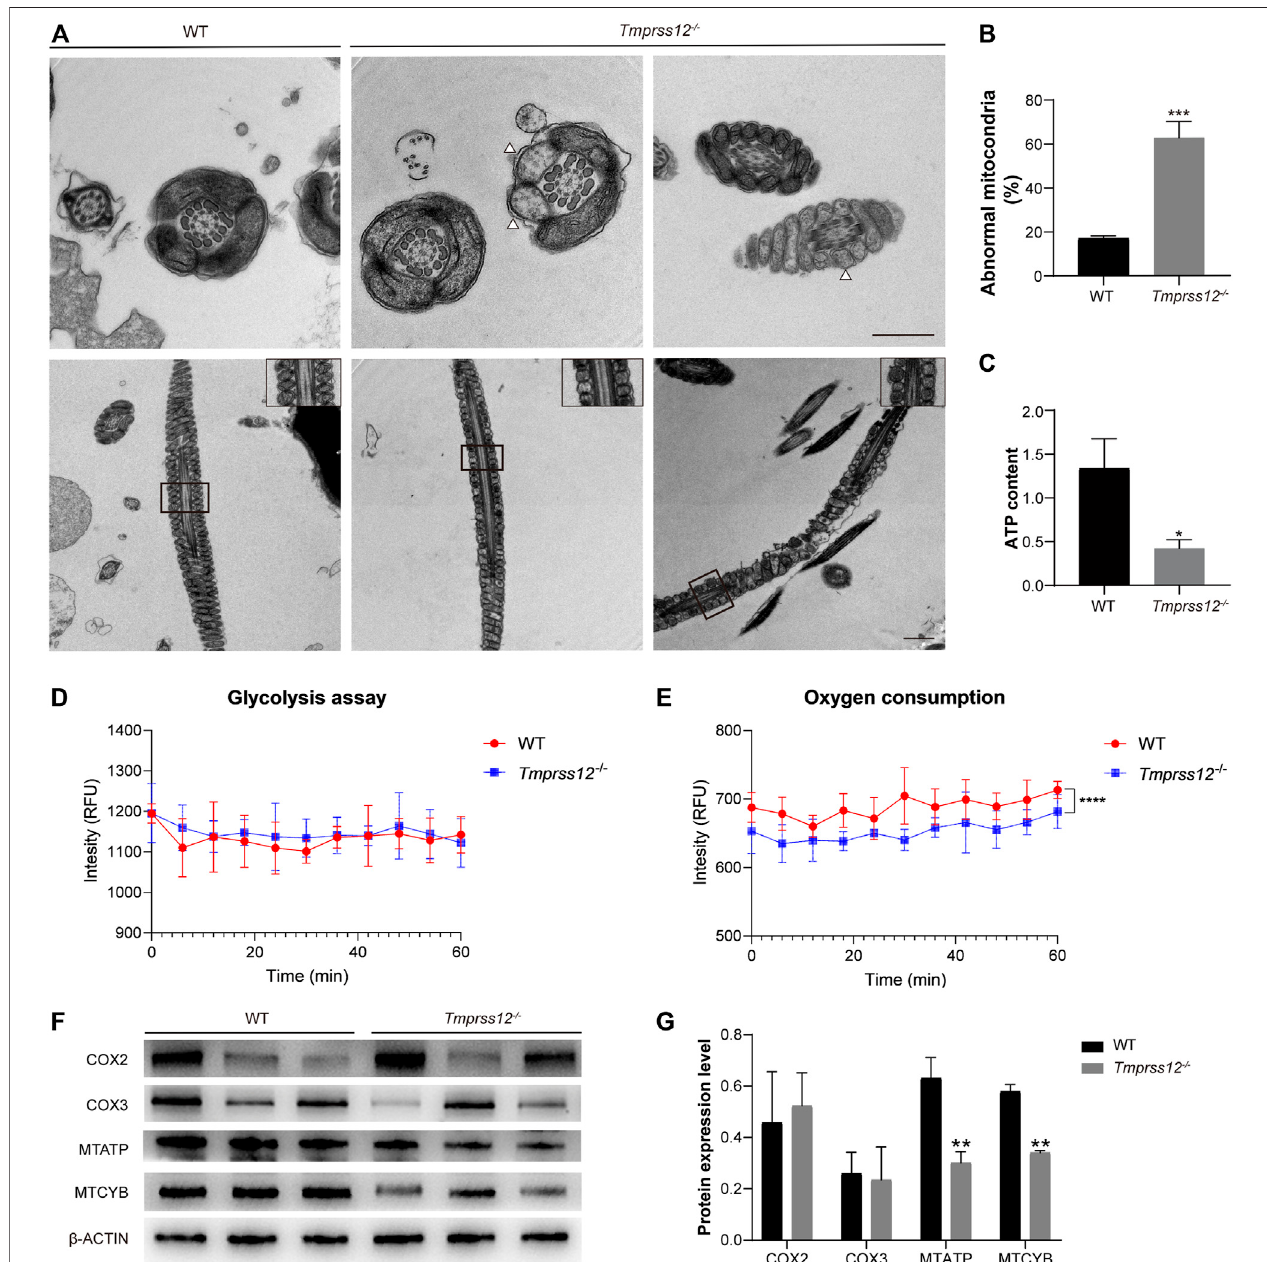
FIGURE 6 | Impaired mitochondrial structure and function in the sperm of Tmprss12 − / − mice. (A) Transmission electron microscopy (TEM) images of the sperm ultrastructure areshown,revealingblurred or absentinner mitochondrial membrane(IMM) cristae (whitearrows).Theimages in theupper rightcorner ofthe second row are enlarged views of the mitochondria. Scale bars: 1 µm. (B) Percentage of mitochondria with an abnormal structure. The percentage was increased in Tmprss12 − / − mice( n =4).Dataarethemean±s.d. ppp p < 0.001. (C) TestedATPcontentsofspermbetweenWTand Tmprss12 − / − mice.Therewerenoenergysubstratesinthe sperm isolationbufferandbackgroundATPwasconsumed beforedetection.TheATPlevelwassigni fi cantlylowerin Tmprss12 − / − mice( n =3).Dataarethemean±s.d. p p < 0.05. (D) Glycolysisassaymeasuredascytoplasmicacidi fi cation.SpermofWTand Tmprss12 − / − micewereextractedfromthecaudaepididymisandsuspendedin respiration buffer, followed by glycolysis measurement for 60 min via fl uorescent emission. There was no signi fi cant difference in glycolysis between sperm of WT and Tmprss12 − / − mice ( n = 3). Data are the mean ± s.d. (E) Oxygen consumption analysis. Sperm of WT and Tmprss12 − / − mice were extracted from the cauda epididymis and suspended in PBS. Then fl uorescent emission was measured and compared during 60 min via fl uorescence spectroscopy. Tmprss12 − / − sperm showed lower oxygen consumption than WT sperm ( n = 3). Data are the mean ± s.d. **** p < 0.0001. (F) Western blot of key markers in the mitochondrial electron transfer chain from sperm of WT and Tmprss12 − / − mice. β -ACTIN was used as an internal control. (G) Grey intensity analysis showing the expression level of the above markers. The expression levels of MTATP and MTCYB were decreased in Tmprss12 − / − mice ( n = 3). Data are the mean ± s.d. ** p < 0.01.